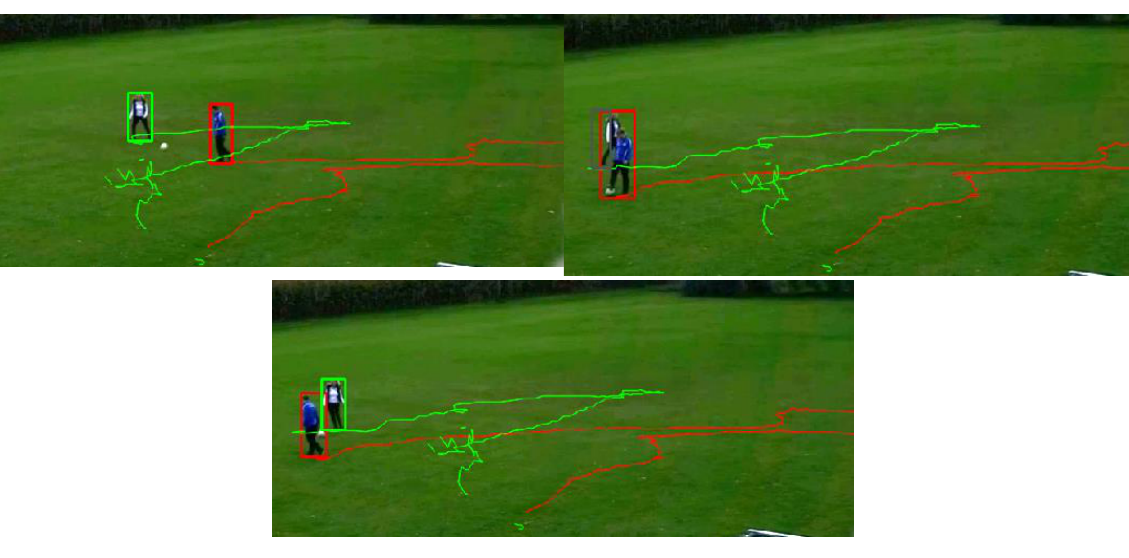
Figure 11. Another situation where the person marked green is occluded for about 1.5 s (8 frames). The assignment is continued correctly after the situation has cleared